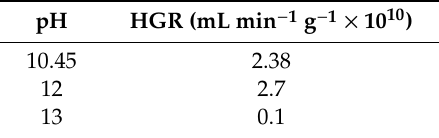
Figure 1. Plot of H 2 generation versus time on the effect of different pH (conditions: 0.1 ng CuNWs, 10 mL of [NaBH 4 ] = 1 wt%, and temperature = 298 K). Table 1. List of H 2 generation rate (HGR) values on different pH values.